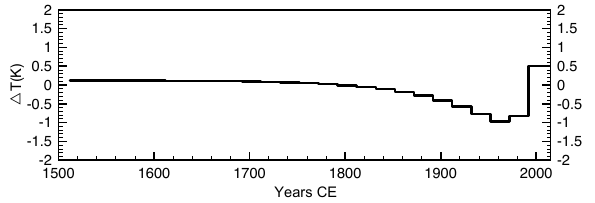
Figure 8. GST history for Vallenar (ala1110-2), with three eigen- values retained. The inversion of the upper and lower bounds of the temperature anomaly or the extremal steady states are not visible because the three lines are superimposed.